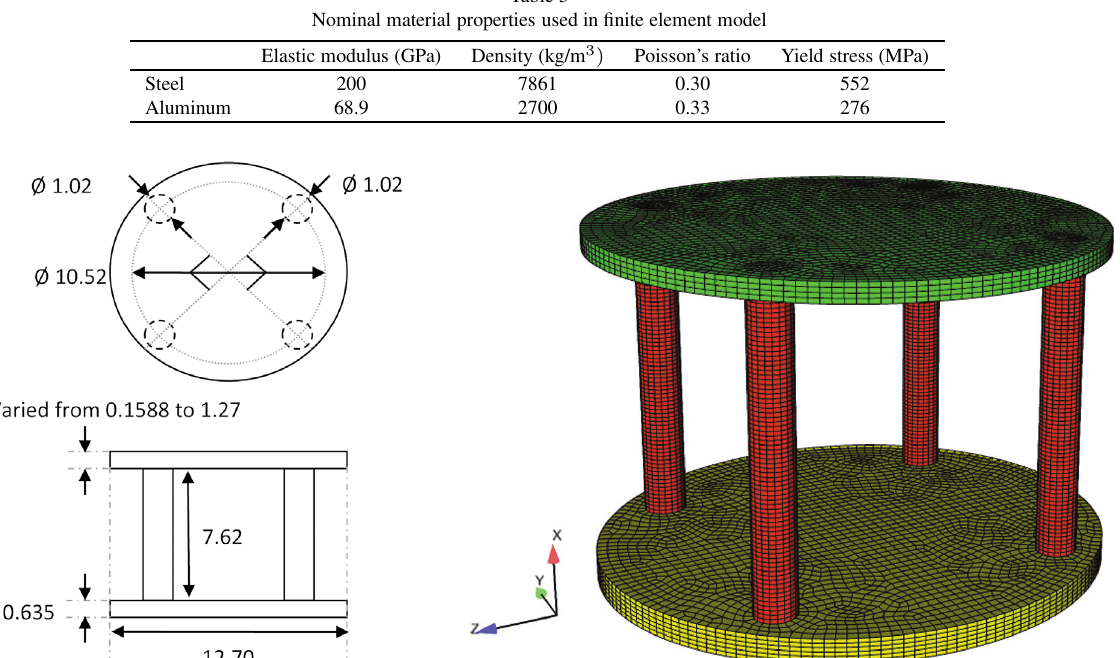
Fig. 8. Finite element model of structure from Fig.